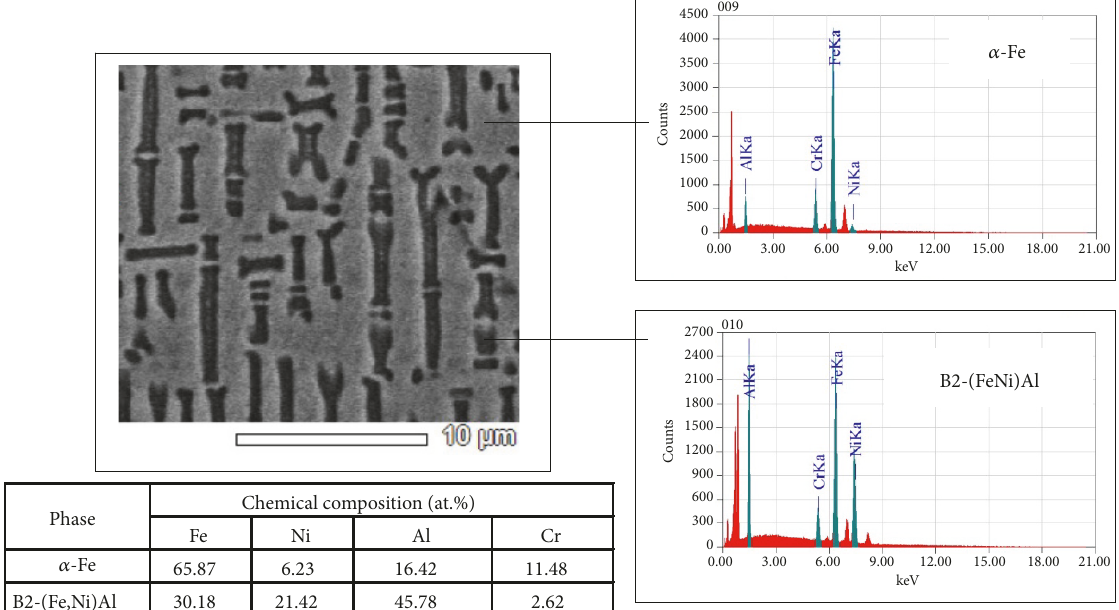
Figure 2: EDX analysis of phases in the sample heated at 800 ∘ C for 150 hrs.